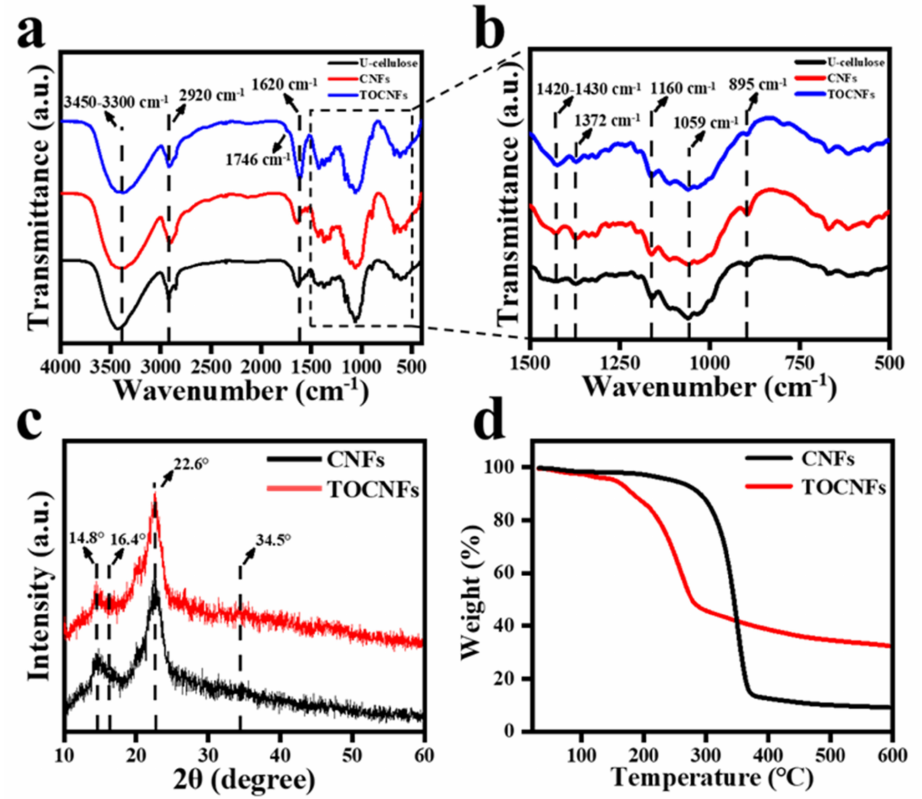
Figure 2. FTIR spectra of U-cellulose, CNFs, and TOCNFs ( a ); amplification of FTIR spectra in the 1500–500 cm − 1 region ( b ). XRD spectra of CNFs and TOCNFs ( c ). TGA curves of CNFs and TOCNFs ( d